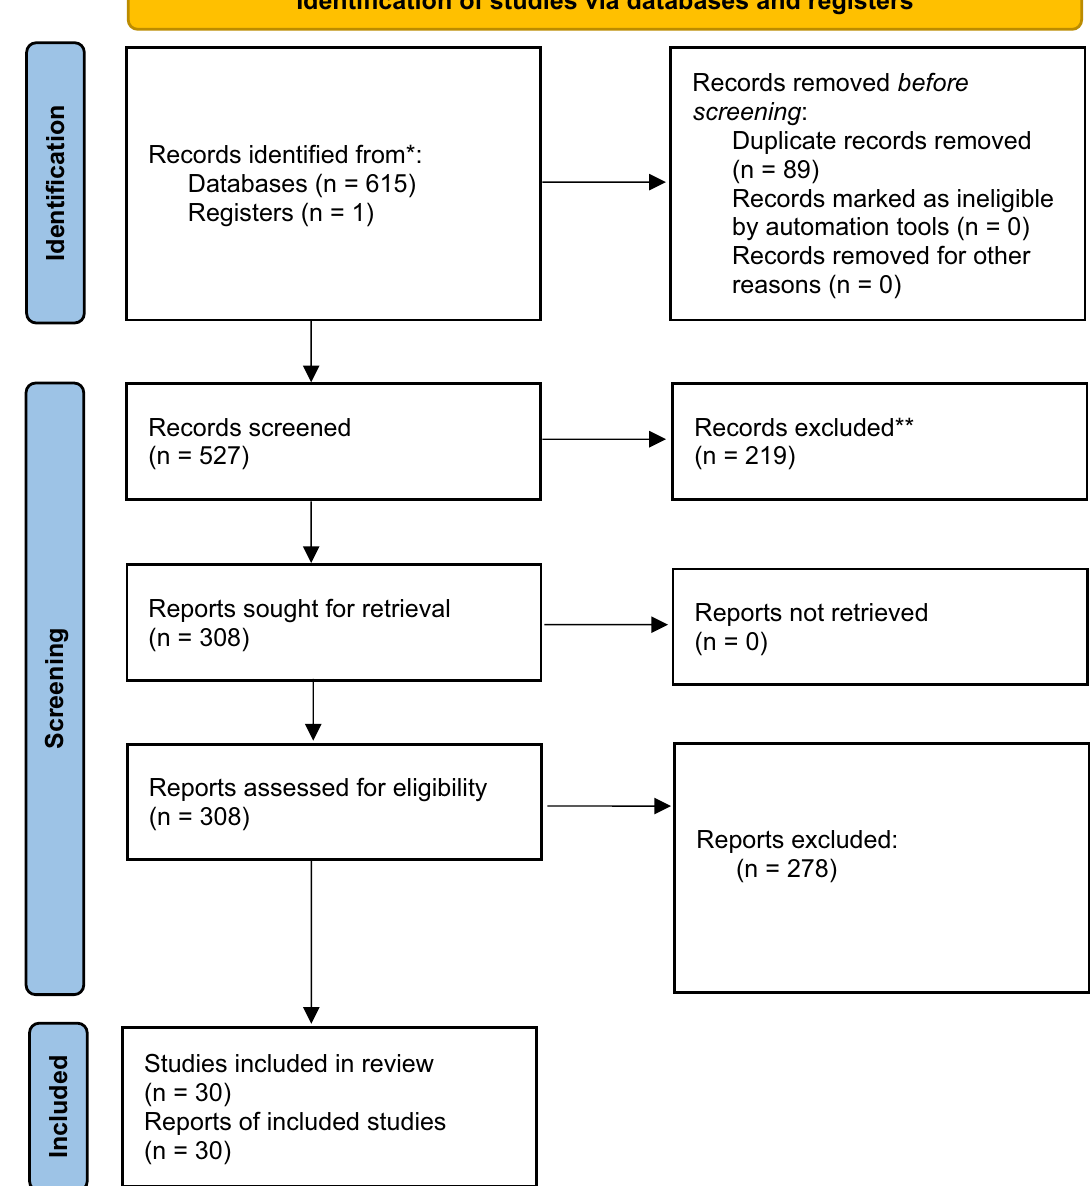
Figure 1. PRISMA 2020 flow diagram for new systematic reviews which included searches of databases and registers